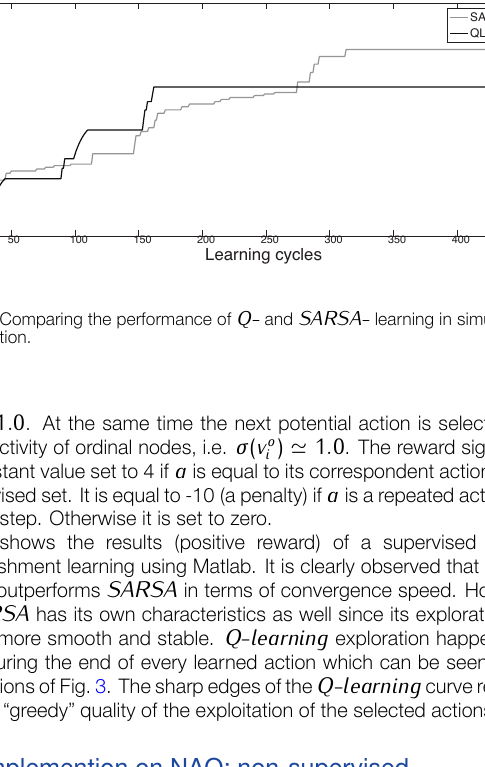
Figure 5. The curveofSARSA fortwo convergedbehaviors: See-FandWalk-F.